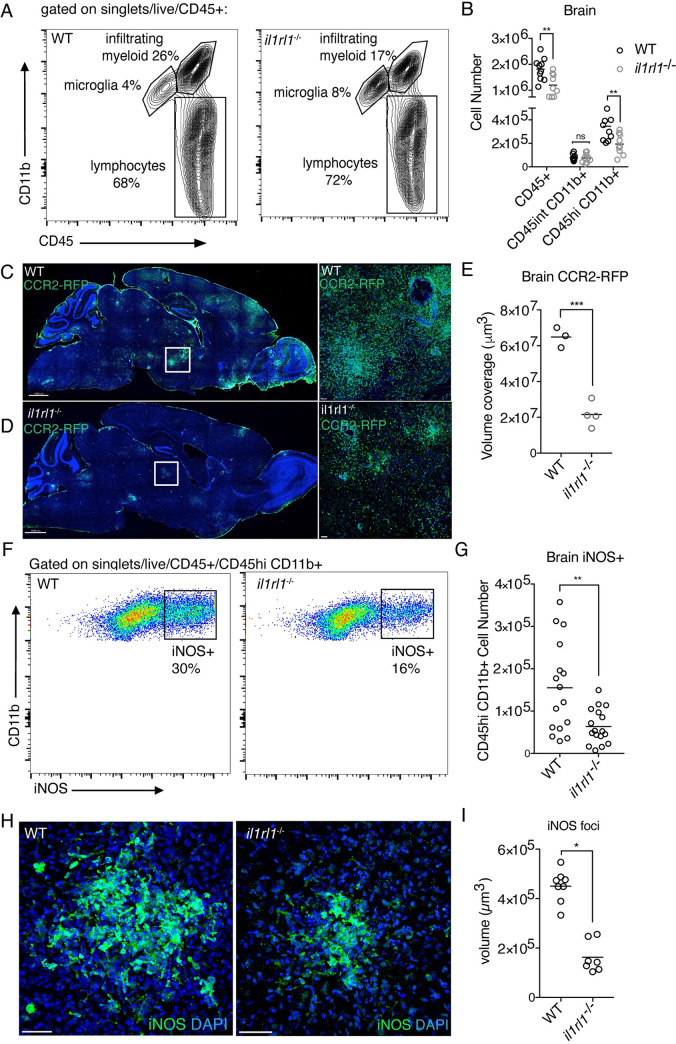
IL-33 signaling is required for the recruitment and anti-parasitic function of peripheral myeloid cells in the brain during chronic T. gondi infection.(A and B) Representative flow cytometry plots (A) and quantification (B) of CD11b+ myeloid cells in the brain 4 weeks post infection. CD45hi expression was used to differentiate infiltrating myeloid cells from CD45int microglia. (C-E) Visualization (C and D), and quantification (E) of infiltrated CCR2+ monocytes by fluorescence confocal microscopy of infected CCR2-RFP reporter mice. il1rl1-deficient mice were crossed to CCR2-RFP mice to assess the contribution of IL-33-il1rl1 signaling to monocyte recruitment. (F and G) Representative flow cytometry plots (F) and quantification (G) of iNOS+ CD45hi, CD11b+ infiltrating cells in the brain. (H and I) Visualization (H) and quantification (I) of the size of iNOS foci in brain tissue by fluorescence confocal microscopy. Statistical significance was determined by randomized block ANOVA when two or more experiments were pooled (B, G, I), and by a two-tailed t-test (E). * = p < .05, ** = p < .01, *** = p < .001. Scale bars indicate 2000μm (C,D) and 50μm (H).